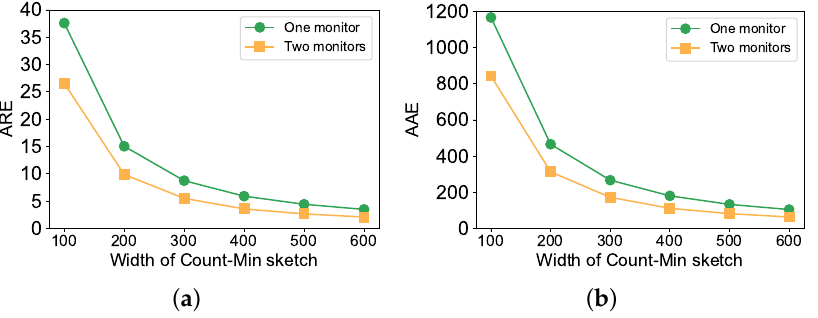
Figure 3. The performances of large flows assigned one monitor and two monitors. ( a ) Performance on ARE; ( b ) Performance on AAE.